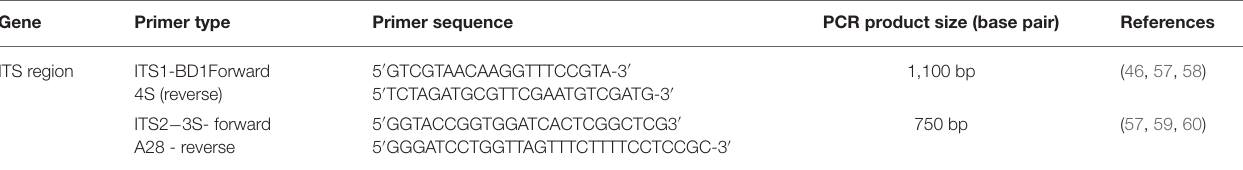
TABLE 1 | The PCR primers for rDNA region spanning the ITS region target